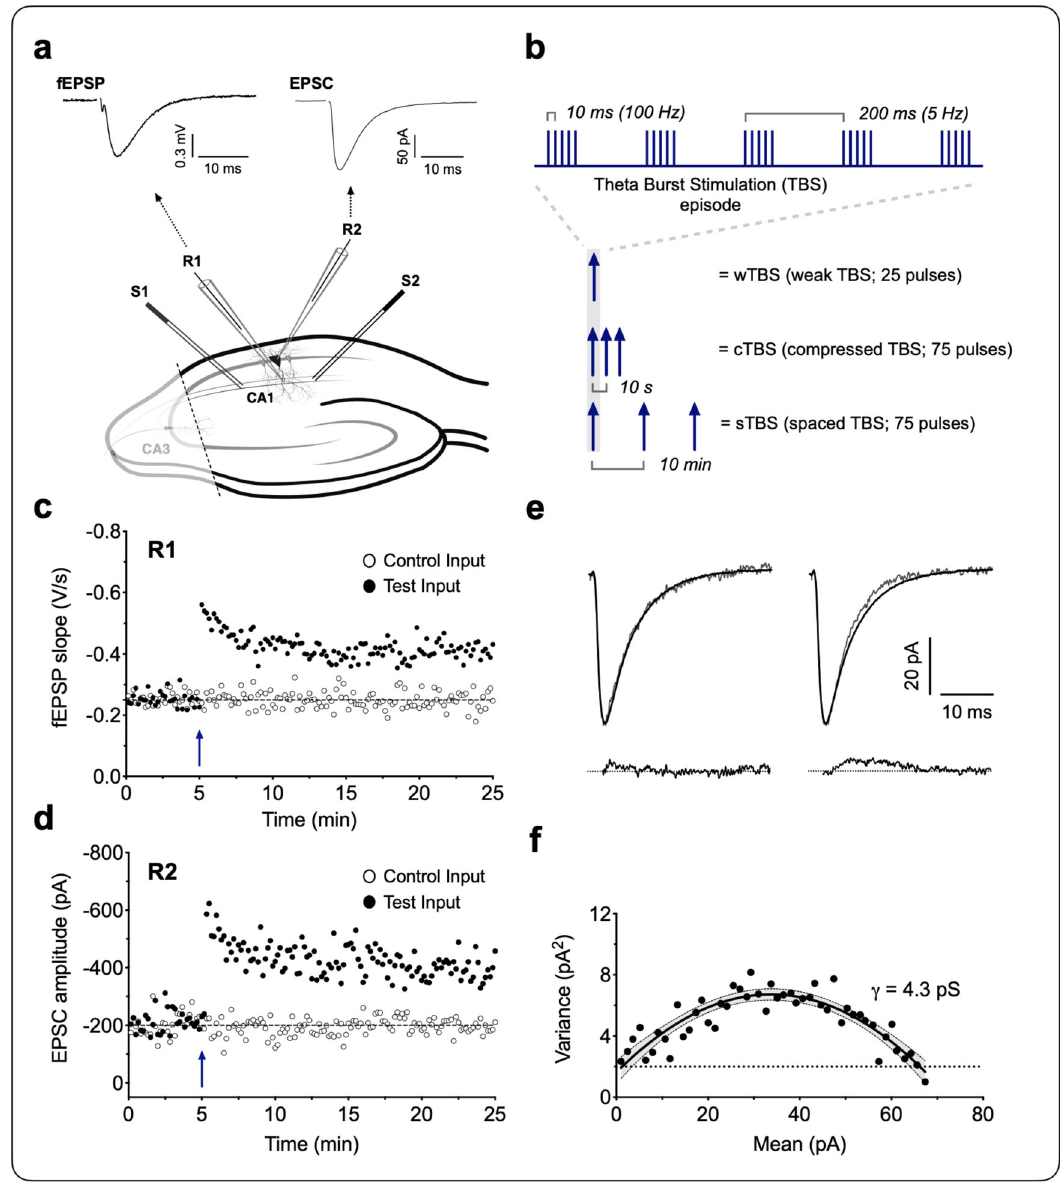
Fig. 1 LTP and non-stationary fl uctuation analysis (NSFA) methodology. a Schematic of a hippocampal brain slice for LTP experiments, and the positioning of recording (R1, R2) and stimulating (S1, S2) electrodes. The CA3 region was cut (dashed line) to reduce neuronal excitability. Representative fi eld and whole cell responses (fEPSP and EPSC), simultaneously obtained from CA1 neurons. Five consecutive responses were averaged and the stimulus artifacts were blanked for clarity. b Induction protocols for weak, compressed and spaced TBS (wTBS, cTBS and sTBS) are graphically summarized. c Representative fEPSP recordings for LTP evoked by a single episode of TBS (weak TBS, blue arrow). d Simultaneously obtained EPSC recordings. e Upper traces are two sets of representative waveforms for individual sweeps (thin lines), superimposed with the scaled mean of 57 EPSCs (thick lines). Lower traces are the subtraction of the scaled mean from the representative individual EPSCs. f Corresponding current – variance relationship to estimate the unitary conductance ( γ ). Fluctuation of the individual decays was plotted against the mean EPSC. Solid line is a parabolic fi t with 95% con fi dence intervals (shaded). Dotted line, the background average